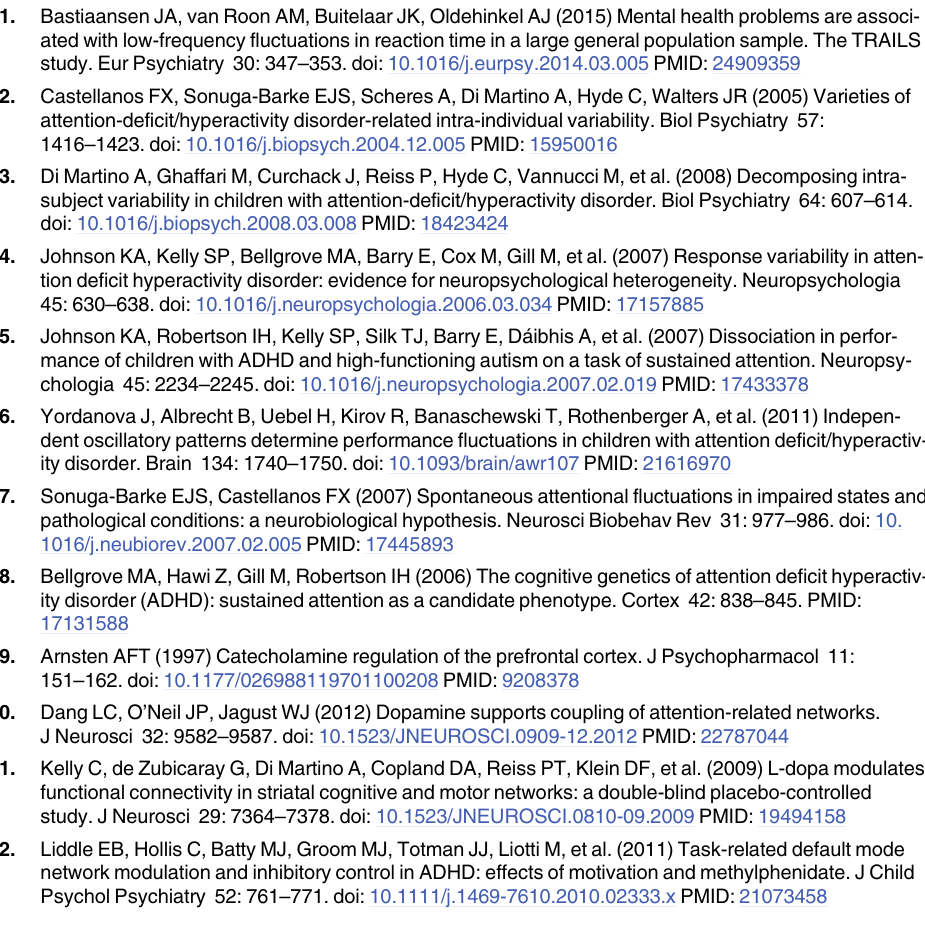
S1 Table. The influence of common catecholamine gene variants on the low-frequency RT fluctuation measures of Slow-4 and